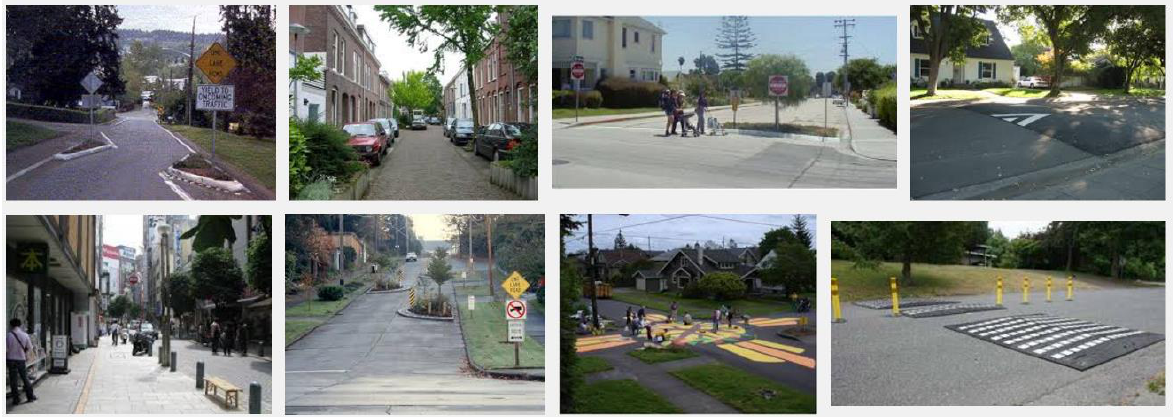
Figure 4. Examples of Traffic Calming Streets.